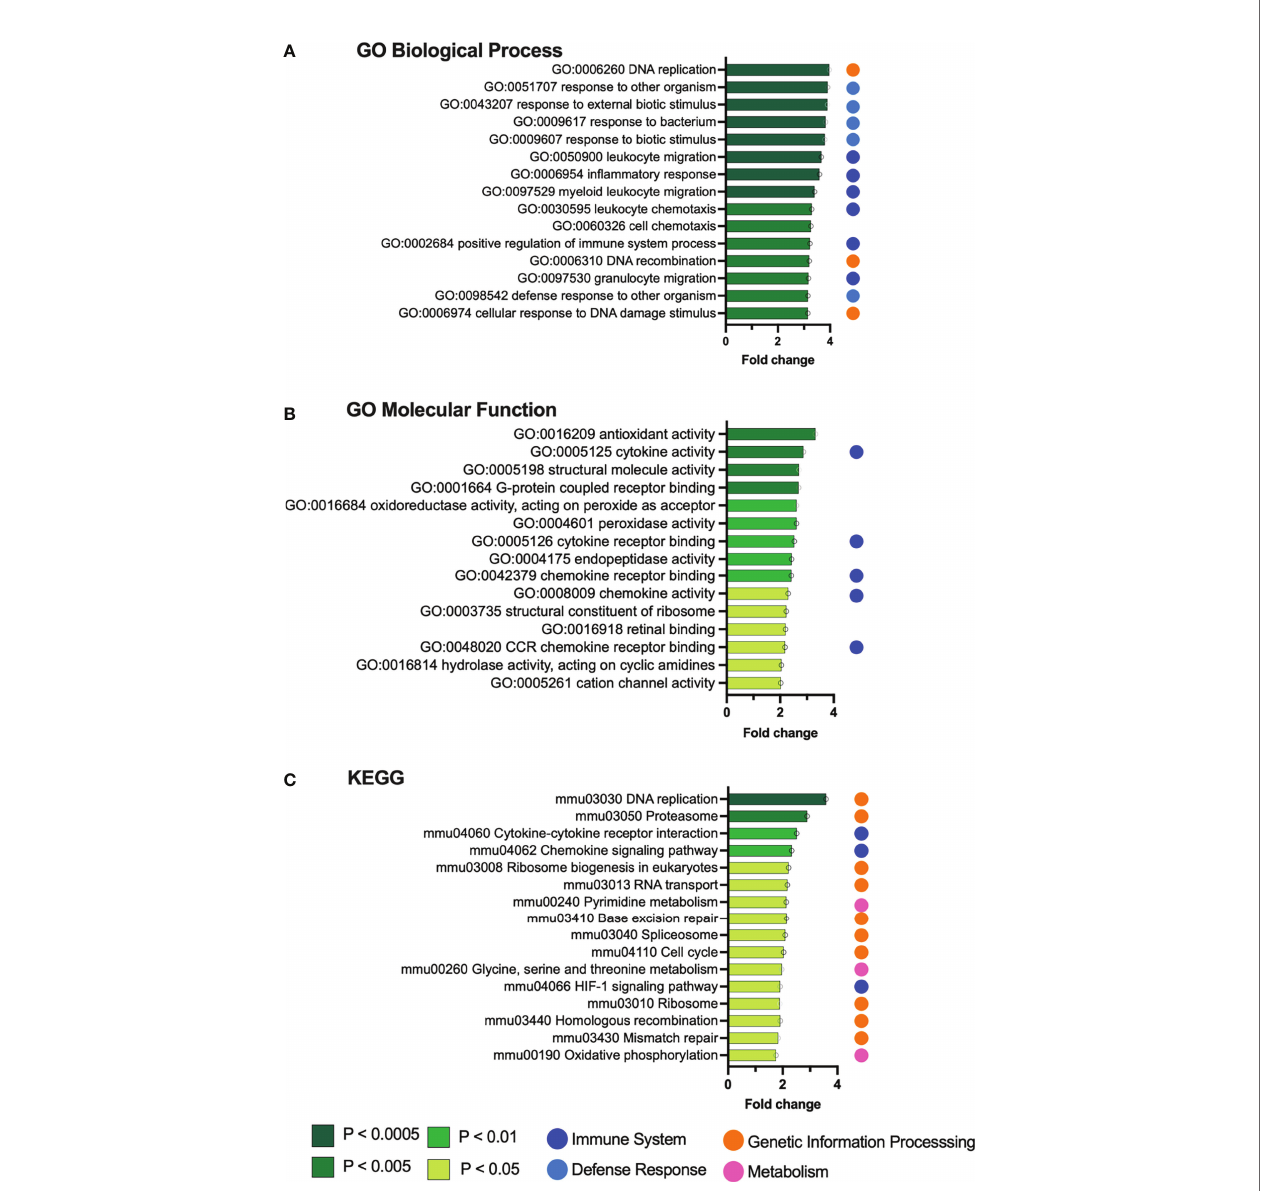
FIGURE 2 | Gene set enrichment analysis identi fi es pathways upregulated by Gardnerella exposures. Graphs depict the top 15 gene sets from the Gene Ontology (A, B) and KEGG (C) databases that were signi fi cantly enriched in the bladders of mice exposed to Gardnerella relative to PBS